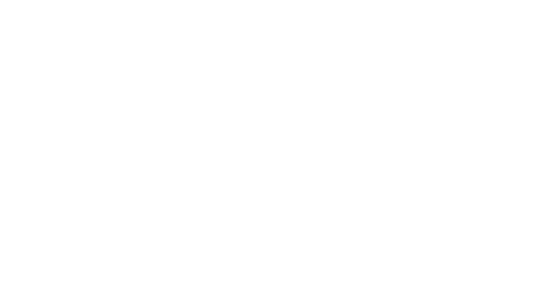
Table 1. Breakdown of YouTube